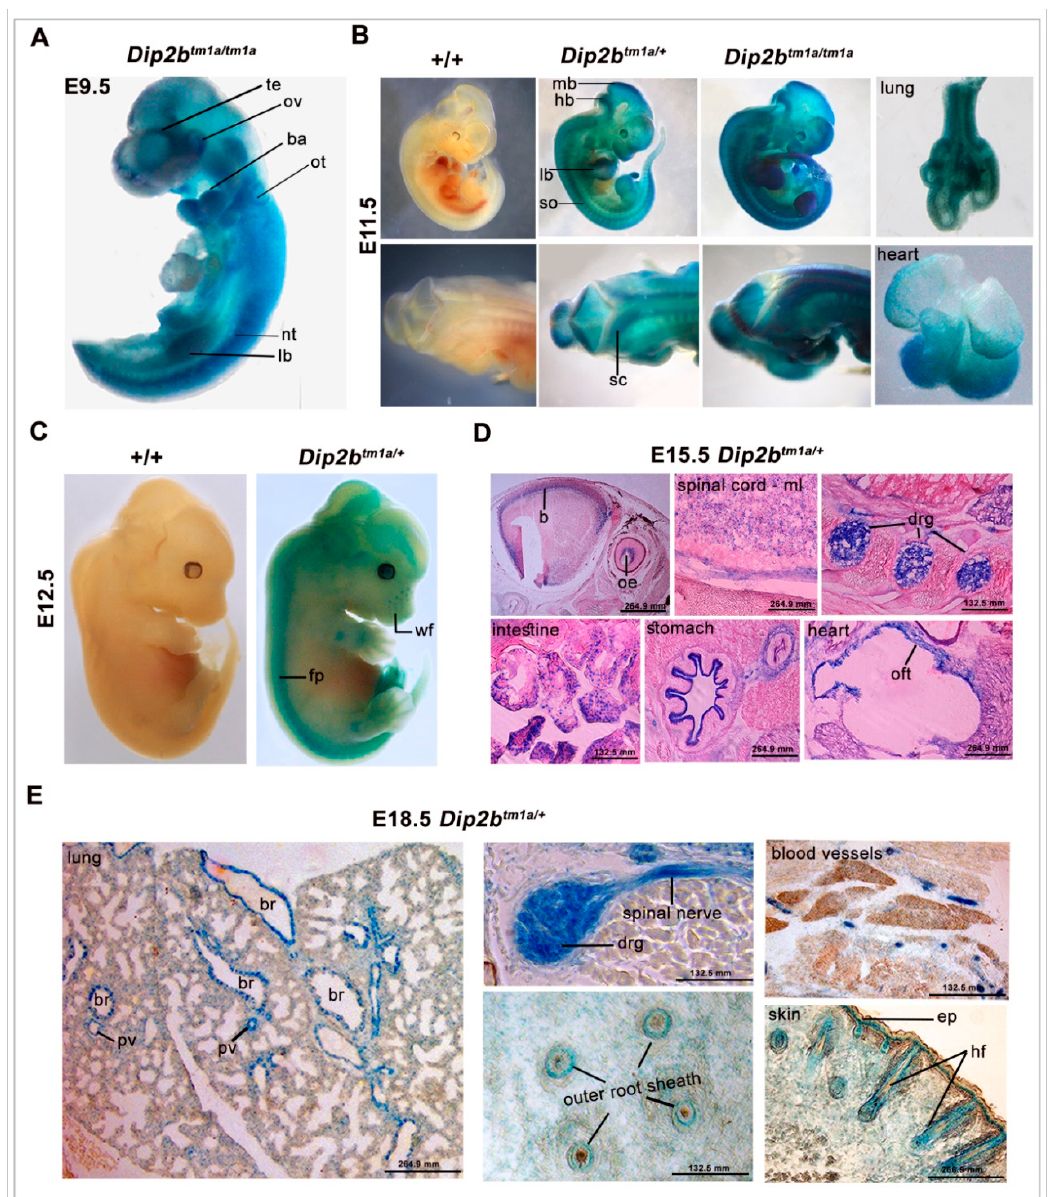
Figure 2. LacZ staining: ( A ) Whole mount of E9.5 Dip2b tm1a /+ mice reveals lacZ expression in brain and dorsal tissues. Staining is intense at telencephalon (te), optic vesicle (ov), branchial arch (ba), limb bud (lb), and neural tube (nt); ( B ) At E11.5, Dip2b expression is concentrated in brain (mid brian, mb and hind brain, hb), dorsal neural tube (dsnt), intersomitic regions (so) and spinal cord (sc). At this stage, signals in heart and lung are also evident; ( C ) At E12.5, LacZ staining expands towards dorsal region specifically in brain (b), floor plate (fp) and whisker follicles (wf). Wild type littermates were devoid of lacZ staining; ( D , E ) Transverse sections of E15.5 and E18.5 Dip2b tm1a /+ embryos were stained for LacZ and counter-stained with eosin. LacZ signals are shown in various neural tissues, in epithelial and endothelial cells of variety of organs. Olfactory epithelium (oe), mantle layer (ml), outflow tract (oft), blood vessels (bv), bronchus & bronchiole (br), pulmonary vessels (pv), epidermis (ep), and hair follicles (hf).